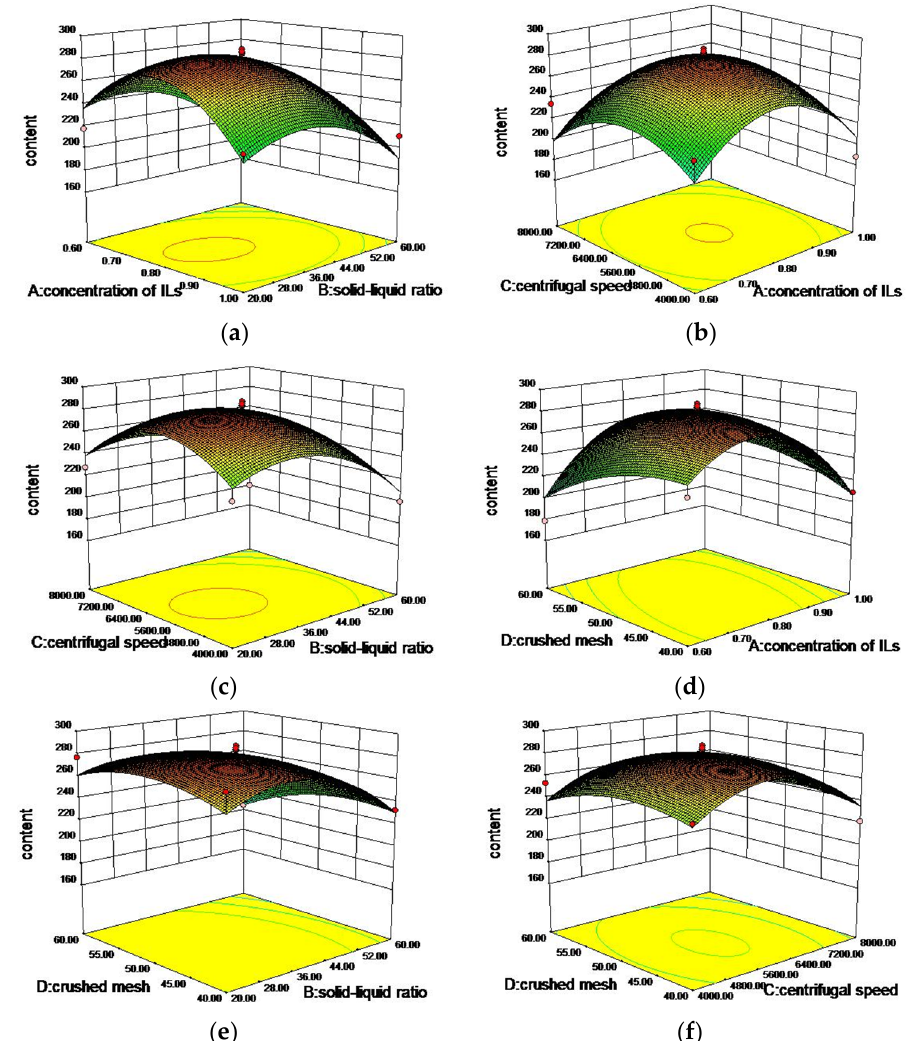
Figure 6. Three-dimensional (3D) response surfaces showing the effects of variables on extraction yield of target analytes. ( a ) Interaction of concentration of ILs and solid–liquid ratio; ( b ) interaction of concentration of ILs and centrifugal speed; ( c ) interaction of solid–liquid ratio and centrifugal speed; ( d ) interaction of crushed mesh and concentration of ILs; ( e ) interaction of crushed mesh and solid–liquid ratio; ( f ) interaction of crushed mesh and centrifugal speed.